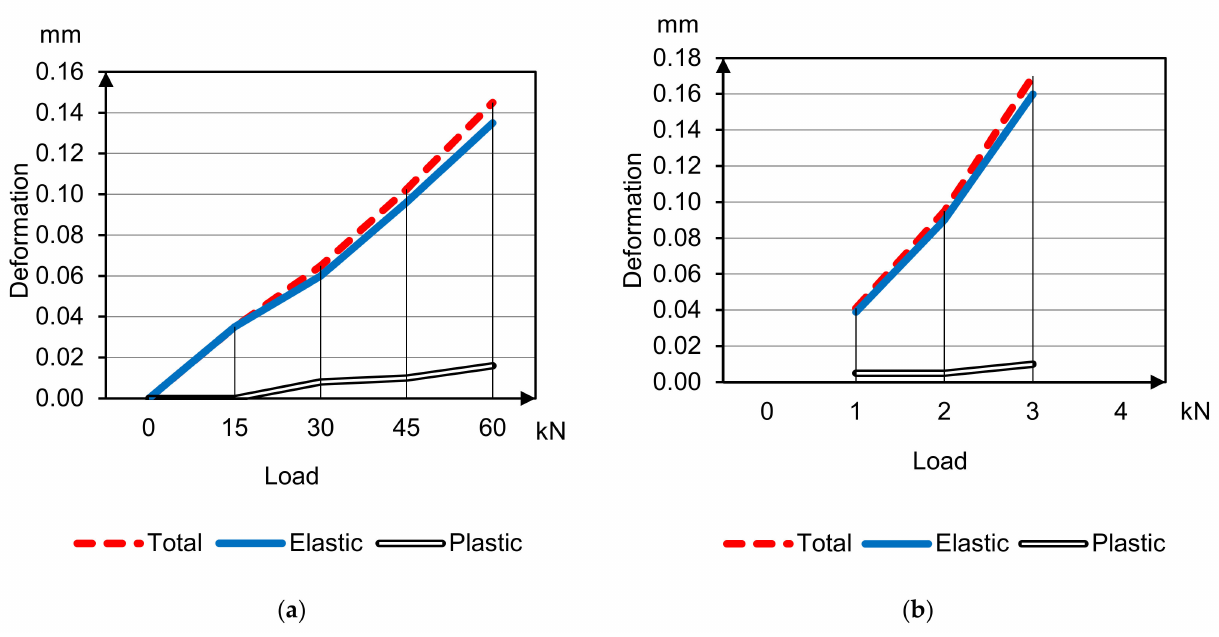
Figure 9. Deformation and deflection curves for concrete 4 under compression ( a ) and bending ( b ) tensile. Curves’ analysis clears specifies of different concrete types deformation under com- pression and bending